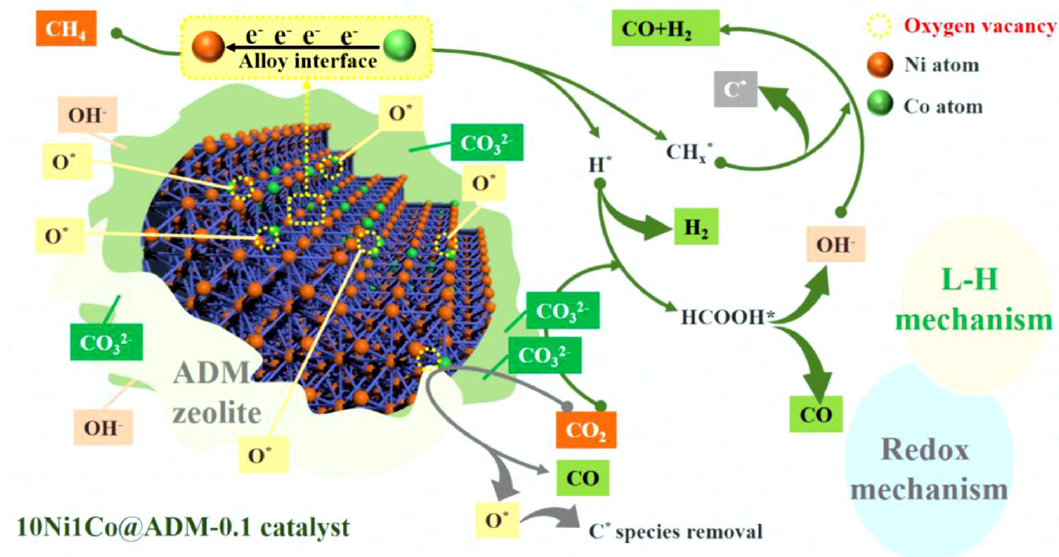
Figure 12. Synergetic effect between the attapulgite-derived MFI encapsulation layers and the Ni-Co alloys for the dry reforming of methane reaction on the 10Ni1Co@ADM − 0.1 catalyst. Reproduced from [81]. Copyright (2023), with permission from Elsevier.